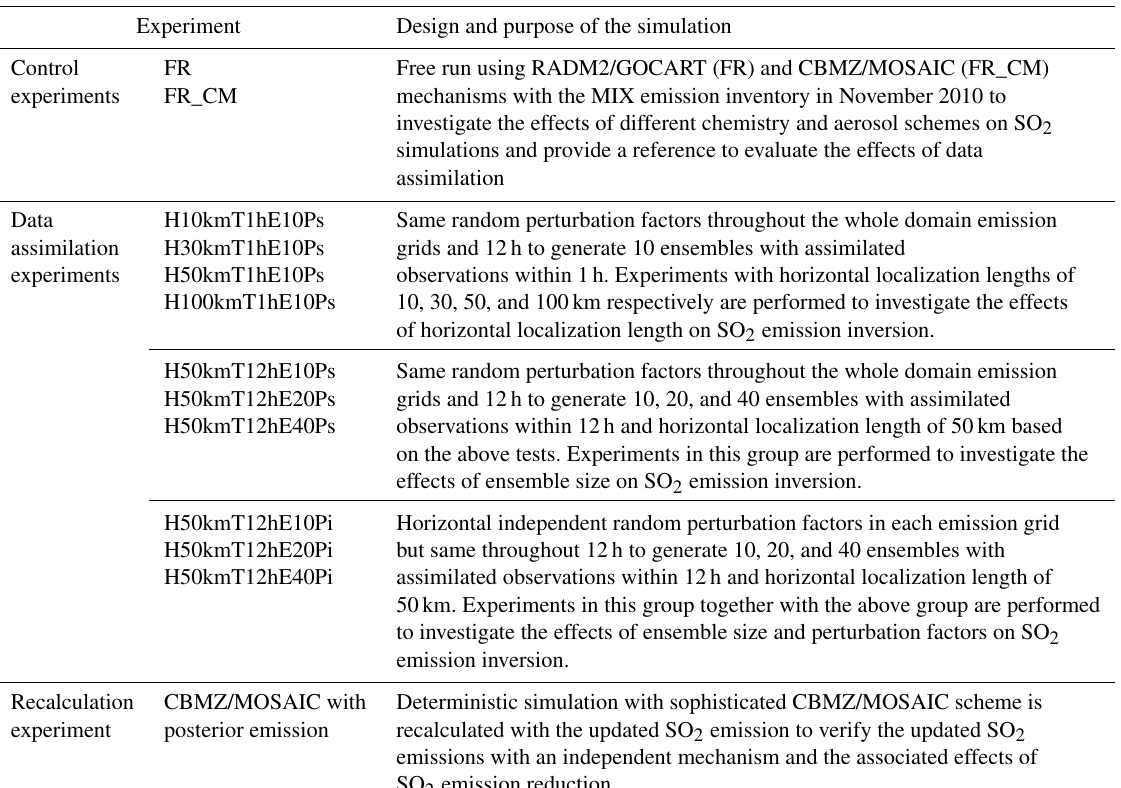
Table 1. Experimental design in this